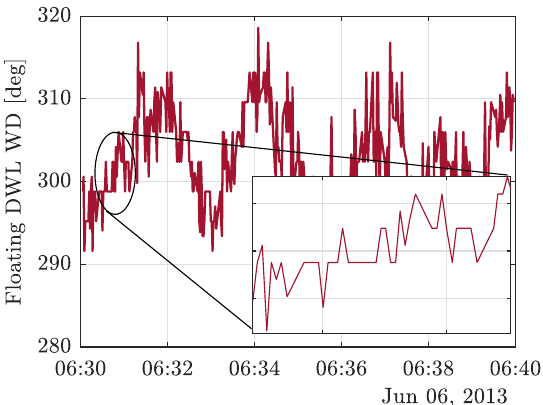
Figure 7. WD time-series measured by the FDWL at 100 m height, showing the so-called “granularity” effect.